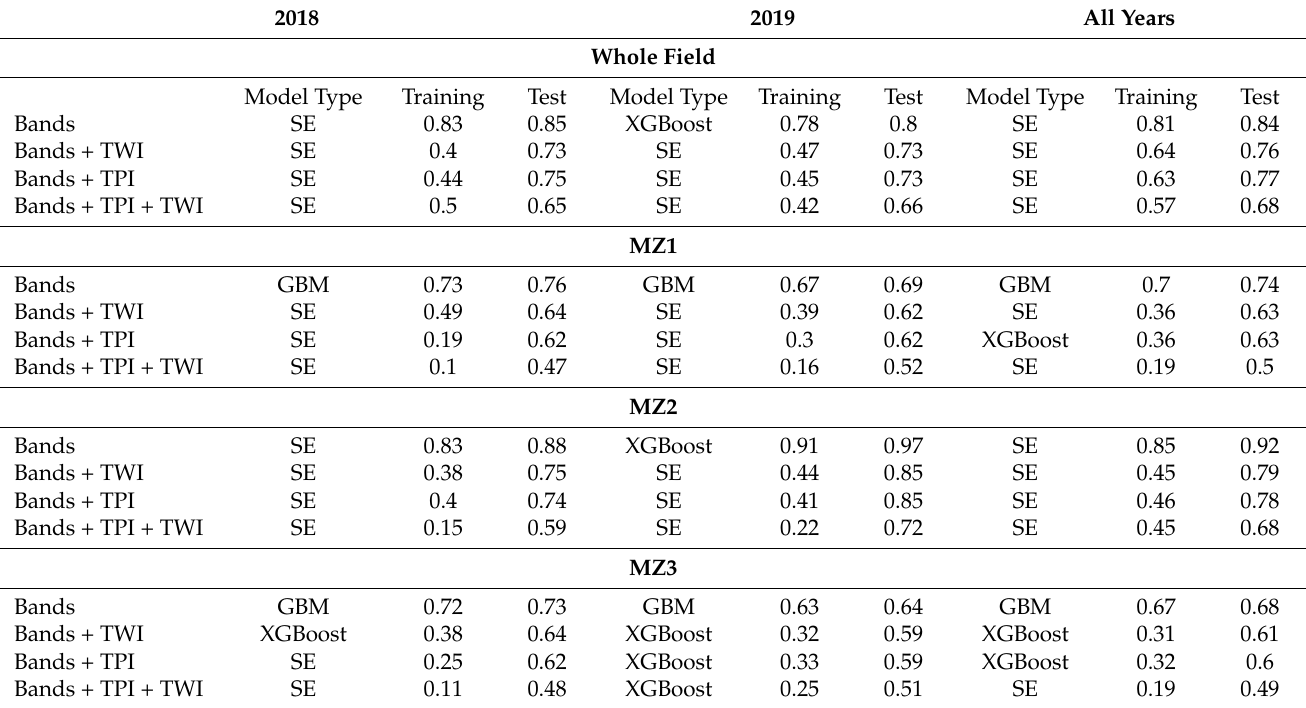
Table 5. Results for training and validation of best models in terms of mean absolute error (MAE, Mg/ha) using data from 2018, 2019, and both years